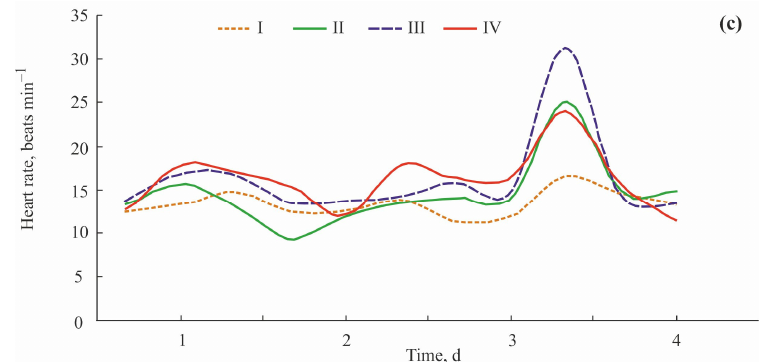
Figure 6. Heart rate variations in blue mussels Mytilus edulis from the White Sea (modified from [88,89]): ( a ) exposure to diesel fuel (I—control, 0 μ g L − 1 ; II—0.35 mg L − 1 ; III—1.88 mg L − 1 ; IV—8.41 mg L − 1 , V—38.8 mg L − 1 ), ( b ) exposure to Cu (I—control, 0 μ g L − 1 ; II—5 μ g L − 1 ; III—50 μ g L − 1